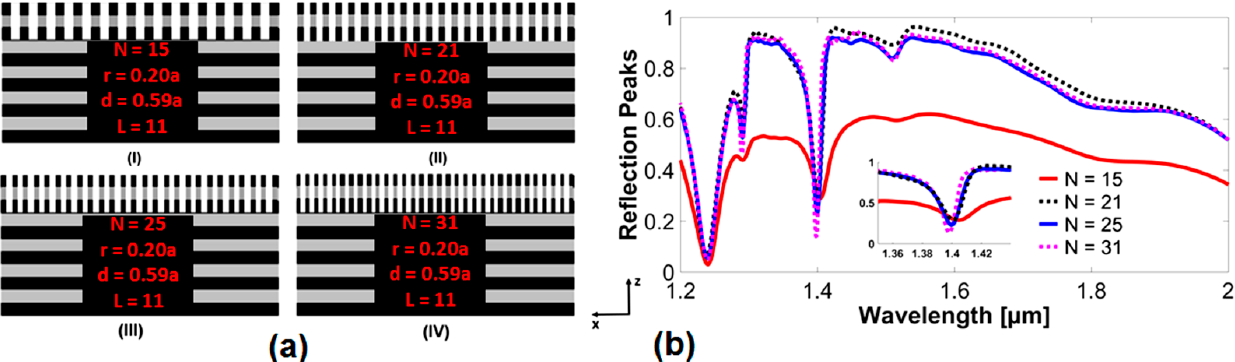
Figure 8. ( a ) Finite 2D-FDTD simulation models of DBR-PhC structures with variation in number of PhC elements as follows: (I) N = 15, (II) N = 21, (III) N = 25, and (IV) N = 31, and with r = 0.2 a and d extending to three DBR layers. ( b ) Reflection spectra of the DBR-PhC structure with variation in the number of PhC elements.